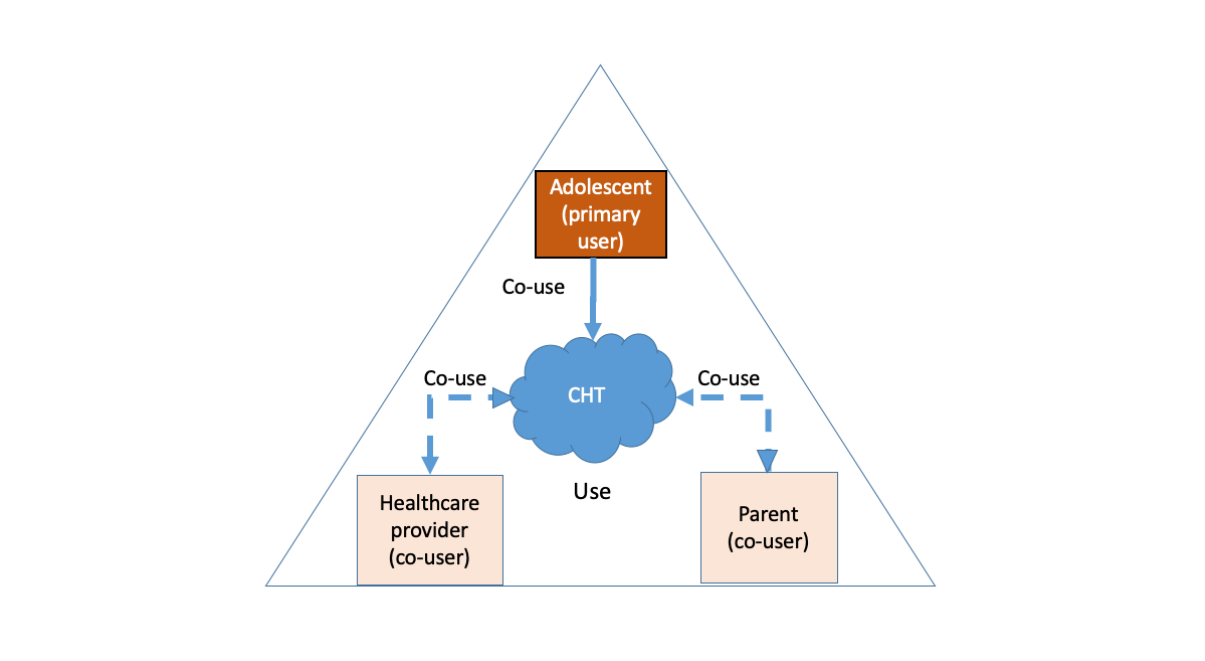
Figure 3. Design perspective of primary and co-user roles in consumer health technology.